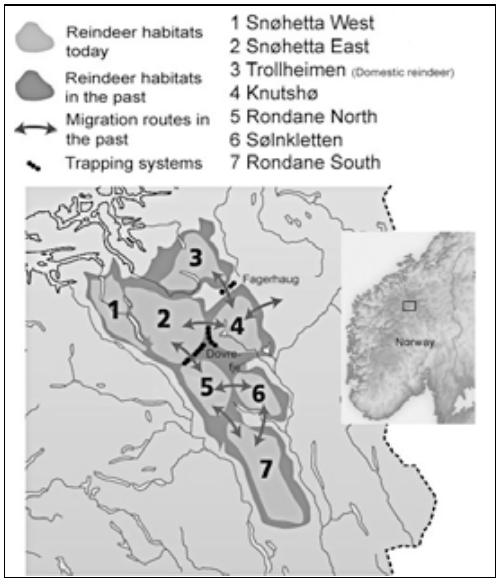
Fig. 1. The reindeer trapping systems at Dovre- fjell and Fagerhaug. The former and pres- ent extent of suitable habitat, and apparent former migration routes in the Dovre-Ron- dane reindeer area, are